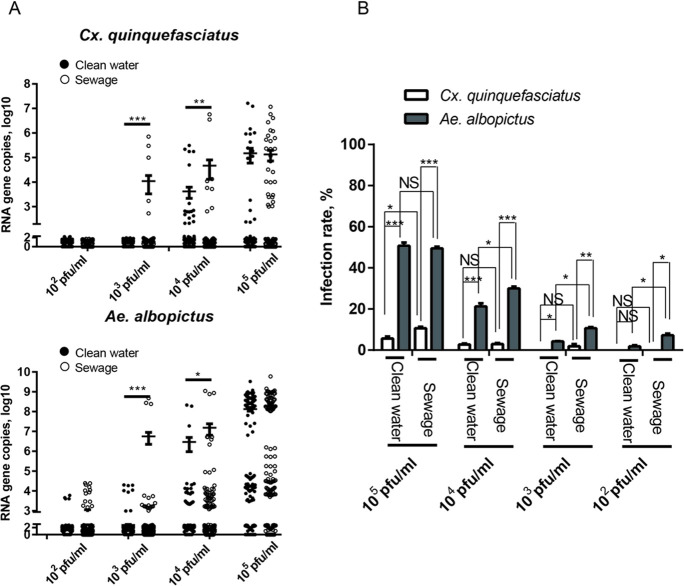
YCV in an aquatic environment can be acquired by Cx. quinquefasciatus and Ae. albopictus.Cx. quinquefasciatus and Ae. albopictus were bred in clean water or sewage with a serial YCV titration (105, 104, 103 and 102 pfu/ml). (A) The emerging adults were reared for an additional 8 days for YCV detection by qRT-PCR. Each dot represents one mosquito body; the results are expressed as the mean ± SEM. (B) Infection rates of Cx. quinquefasciatus and Ae. albopictus are represented as the ratios of mosquito infection. The results are expressed as the mean ± SEM. The results were analyzed using the unpaired t-test. A P value of < 0.05 indicates statistical significance. P < 0.05, *; P < 0.001, ** and P < 0.001, ***.